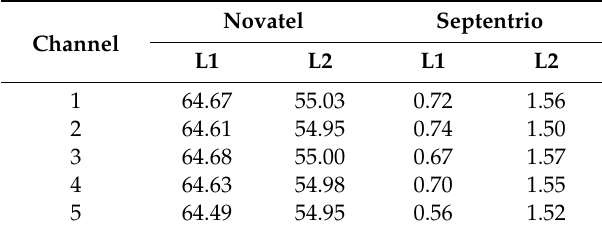
Table 1. Channel delay statistics under GPS L1 / L2 (unit: ns).